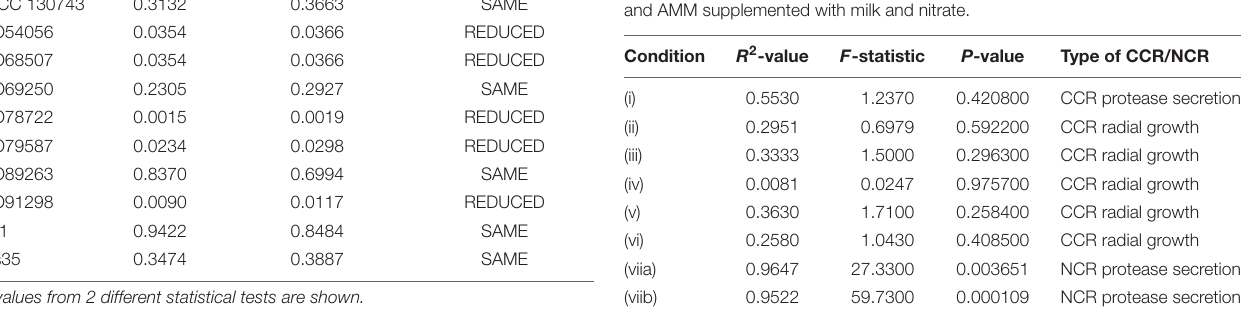
TABLE 3 | Regression analysis between murine median survival and: (i) minimal medium supplemented with milk, milk and glucose, milk and 2DG or milk and acetate; (ii) minimal medium supplemented with glucose, glucose and 20 mM AA or glucose and 40 mM AA; (iii) lactate or lactate and 2DG; (iv) acetate or